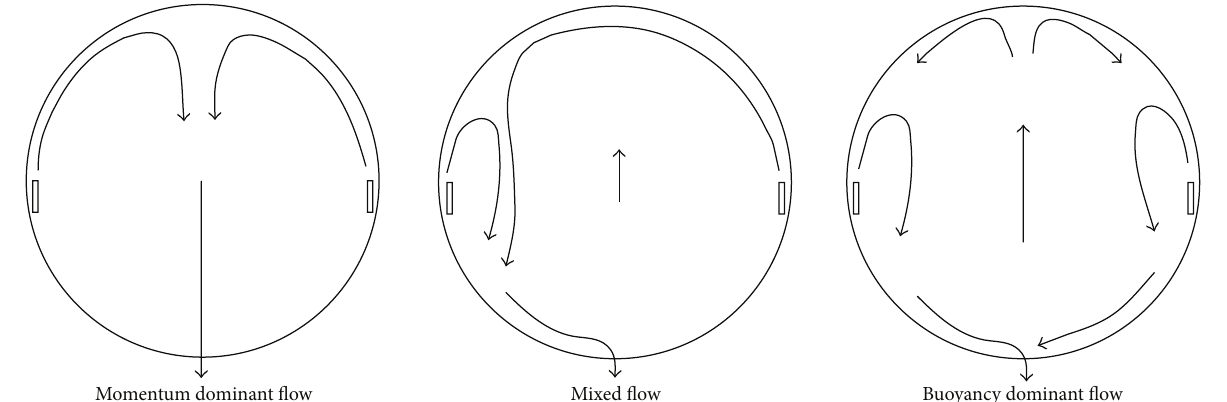
Figure 3: Flow characteristics in the moderator